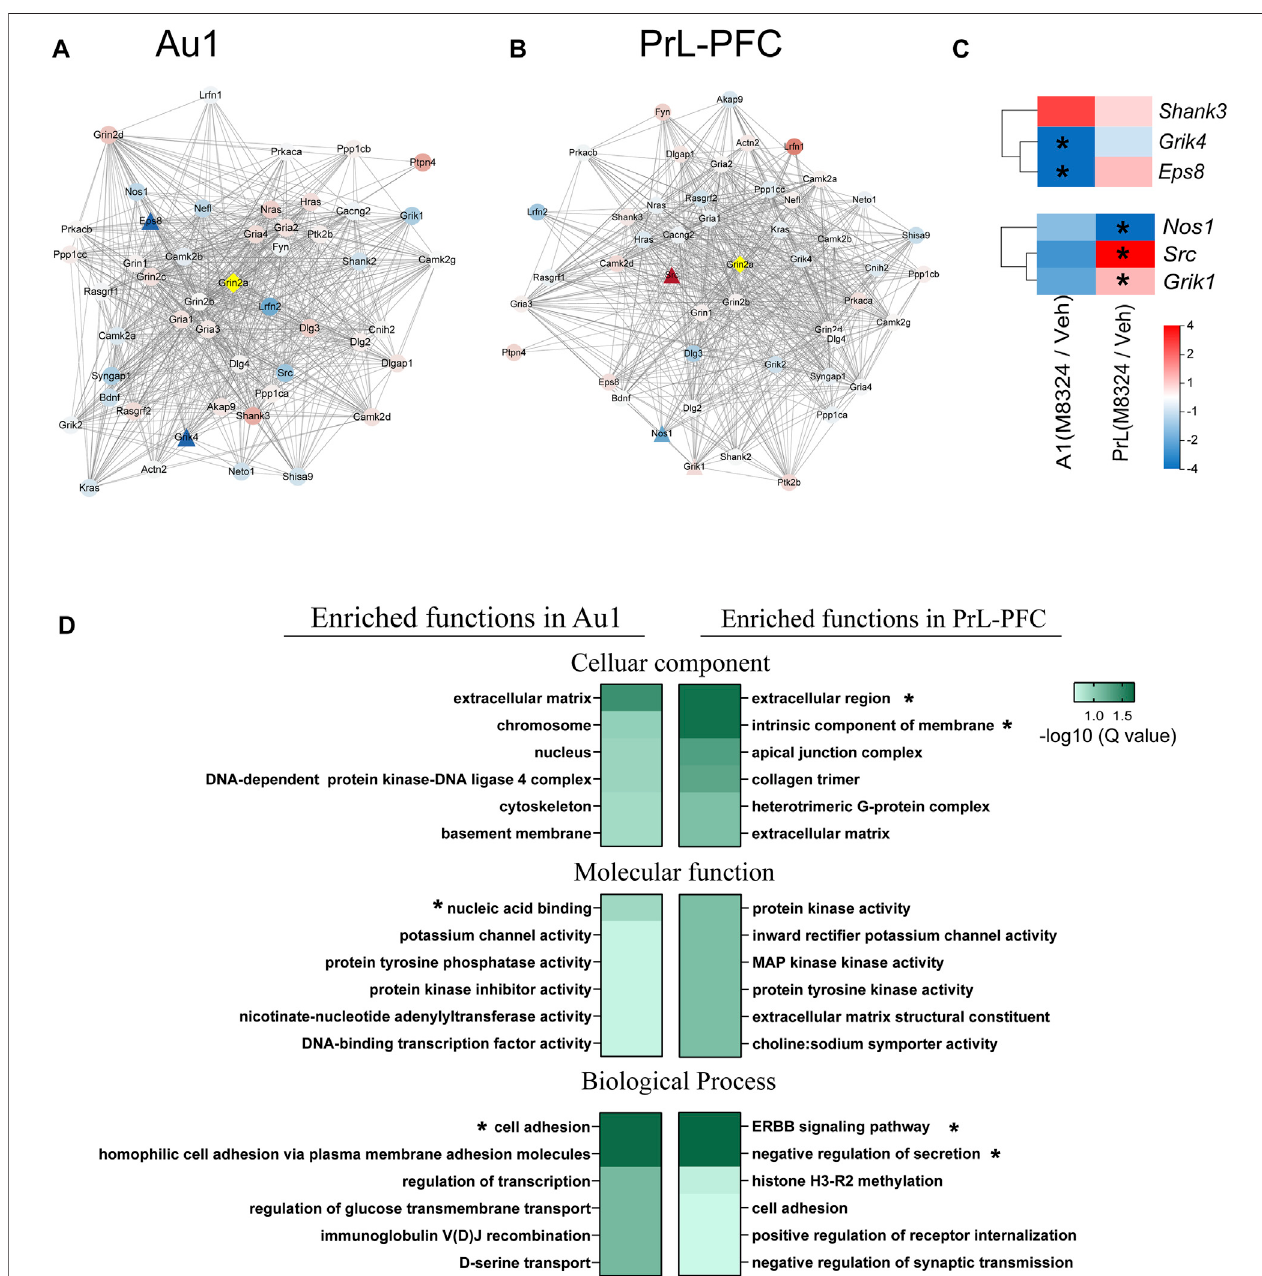
FIGURE 7 | GO functional enrichment and protein-protein interaction of Grin2a in Au1 and PrL-PFC after 7-days M-8324 treatment. (A – B) Protein-protein interaction (PPI) network of Grin2a with the fi rst shell of 50 nodes shown. The active interaction sources came from textmining, experiments, databases, co-expression, neighborhood, gene fusion or co-occurrence. Gene expression difference in Grin2a -interacting proteins after M-8324 treatment in Au1 and PrL-PFC were shown in (A,B) , respectively. (C) Heatmaps of the signi fi cantly changed nodes from data in (A,B) . For panels A – C , fold changes are shown in color gradient, the redder the colorthegreatertheup-regulation,and thebluerthecolorthegreaterthedown-regulation. Signi fi cantlydifferentiallyexpressed genesbetweenVehandM-8324 groups are represented by triangles while the rest by circles. (D) Biological functions of all up-regulated DEGs using a GO enrichment analysis, with top 6 enriched term shown. Colors represent the enriched Q-value, the deeper the color the smaller the Q-values. * Q value < 0.05.